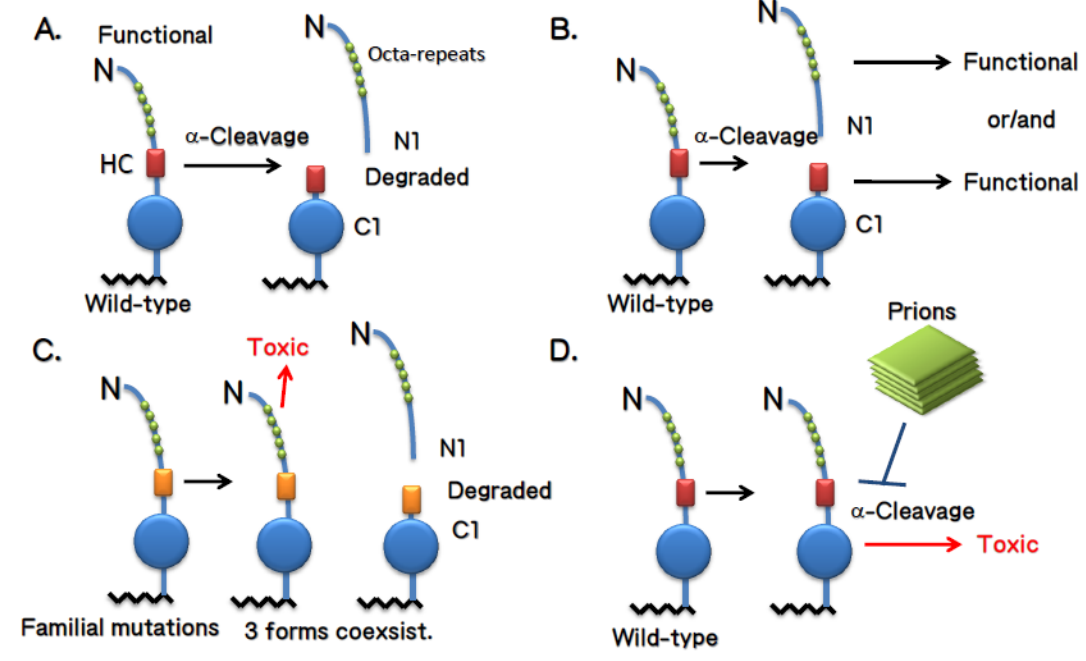
Figure 4. (A) Full-length PrP C has a function so that it is immediately cleaved at  - cleavage site after activation. (B) Either N1 or C1 is an active form so that it is cleaved at  -cleavage site to activate it. (C) PrP C with mutations is not completely cleaved so that the uncleavable PrP show some residual toxicity. (D) Spontaneously generated PrP Sc on one gene or derived from single cell blocks the  -cleavage of the remaining PrP C , resulting